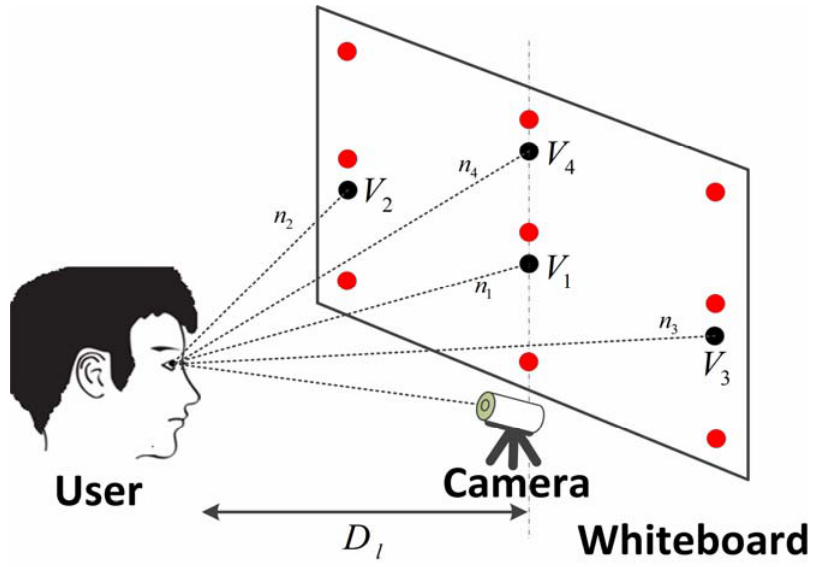
Figure 20: Experimental